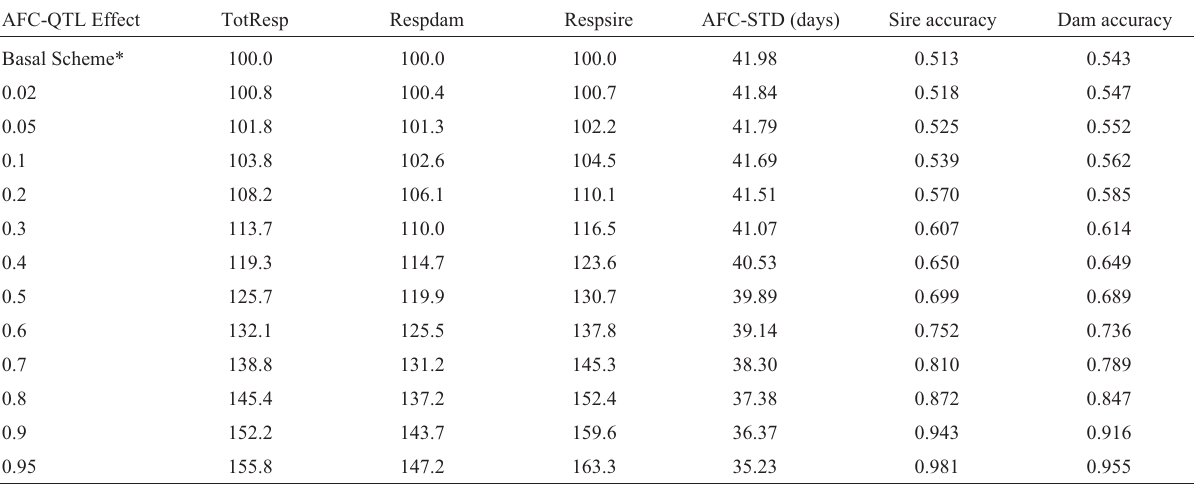
Table4 -SchemeA1:Single-stagemarkerassistedselection.Ageatfirstcalving(AFC)quantitativetraitlocus(QTL)totalresponse(TotResp);response due to selection of dams (RespDam) and sires (RespSire) as a percent of the basal scheme; AFC breeding goal standard deviation (AFC-STD) and the ac- curacy for sires and dams for single-stage marker assisted selection at two-years of age with the AFC-QTL explaining 0.00 to 0.95 of the additive genetic